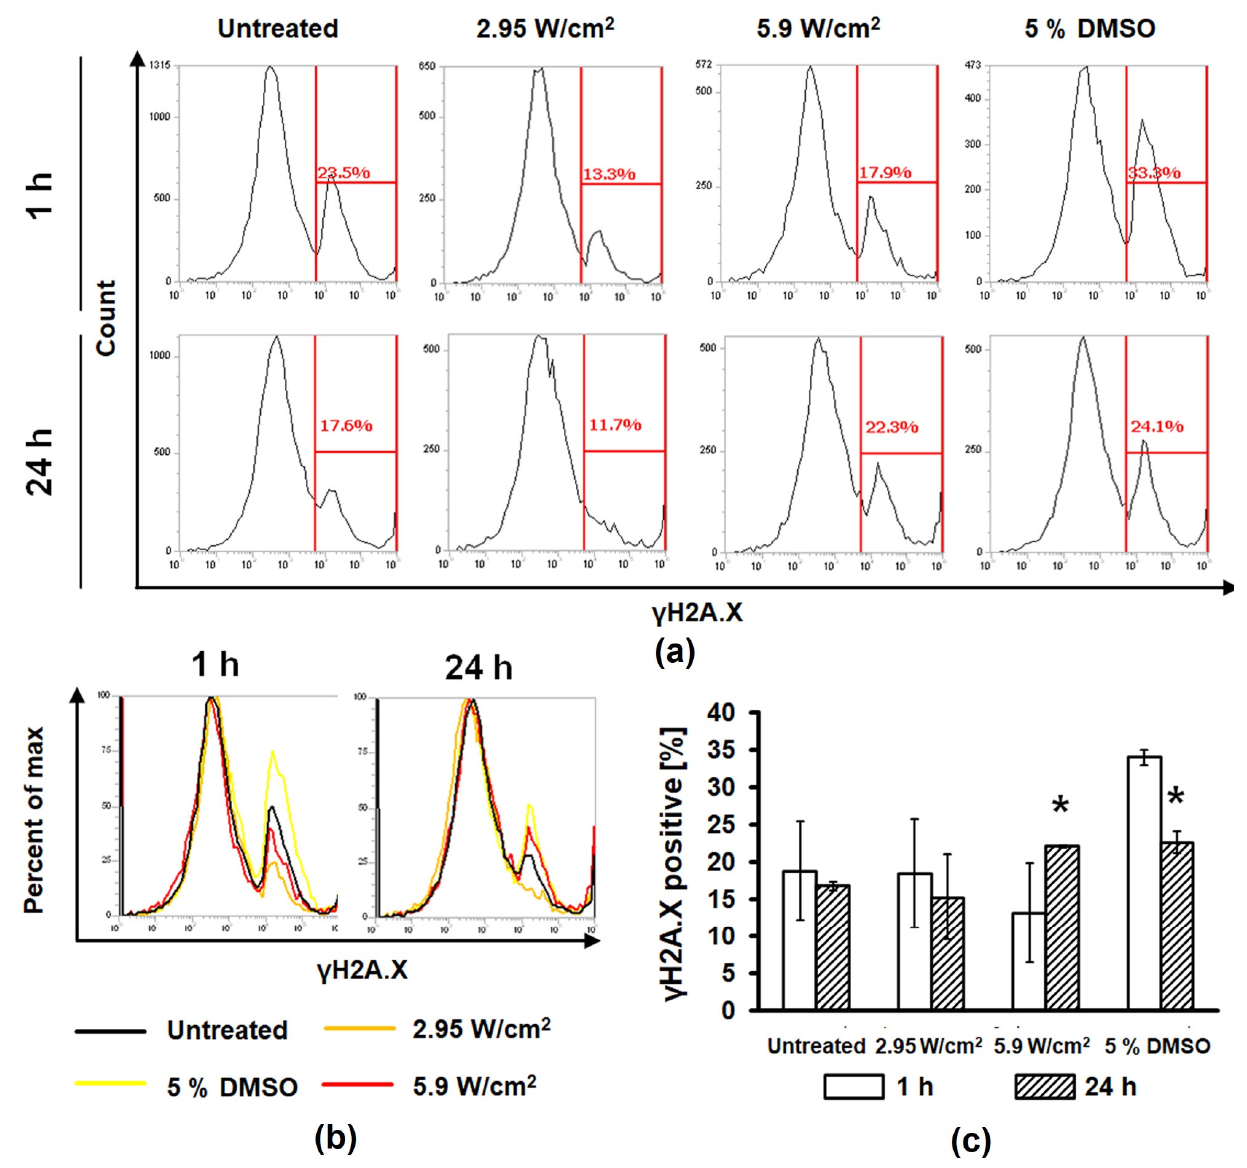
Figure 6. FUS treatment enhanced the number of DNA double-strand breaks after 24 h. ( a ) Representation of γ H2A.X percentages as a function of cell count determined by gating histograms derived from dissociated PC-3 spheroids with flow cytometric analysis 1 and 24 h post-treatment. ( b ) Overlayed flow cytometry images ( c ) and quantified results show an increasing number of γ H2A.X positive cells 24 h after 5.9 W/cm 2 . Data analysis was carried out by one-way ANOVA. * Significantly different from negative control ( p ≤ 0.05).